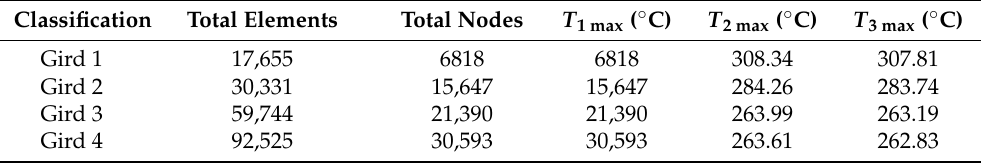
Table 2. Grid independence test.